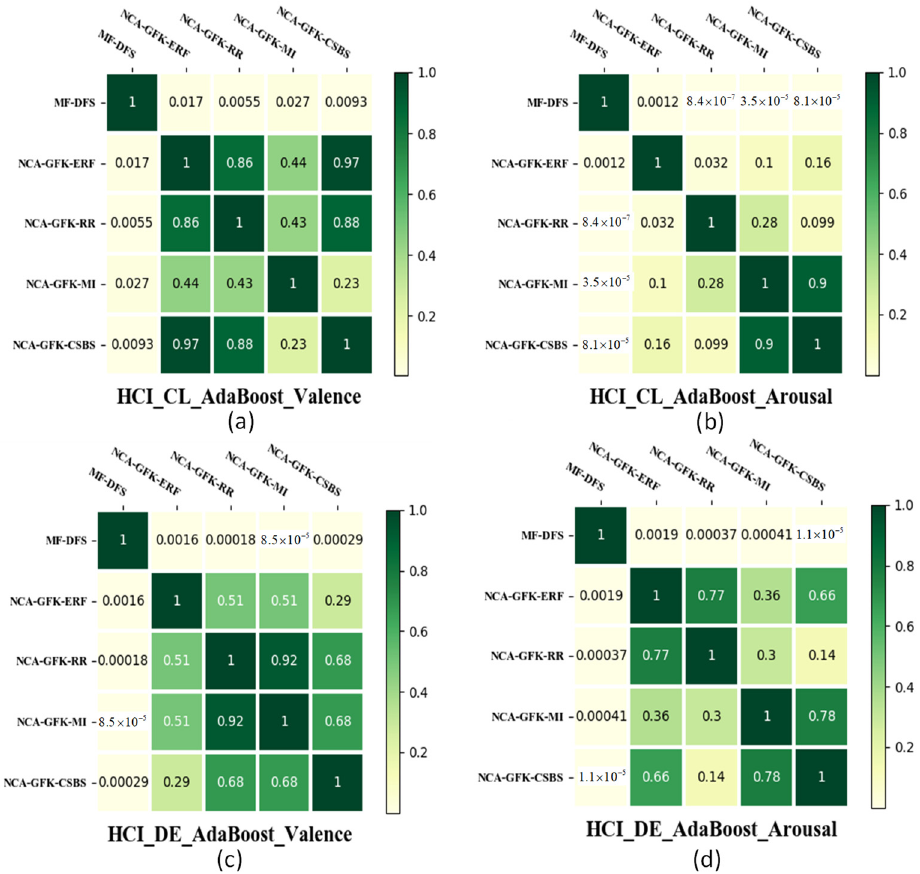
Figure 8. Heat map of the p -values of the paired t -test between different feature selection methods for the MAHNOB-HCI database. The p -values of CL features for the valence and arousal dimensions are shown in ( a , b ), respectively. The p -values of DE features for the valence and arousal dimensions are shown in ( c , d ), respectively.